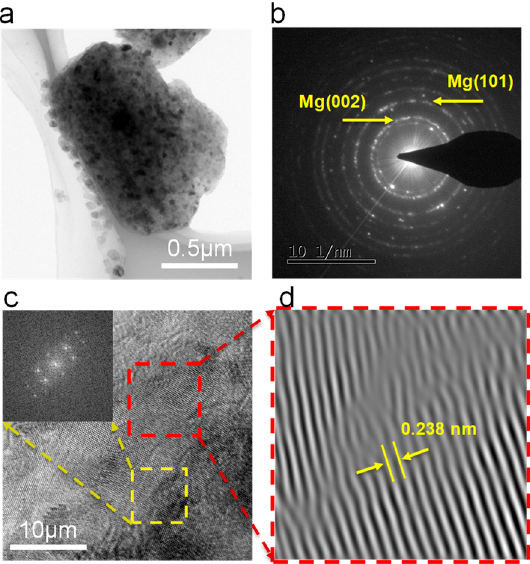
Figure 4. TEM analysis of Mg-Zn powder after milling for 30 h: ( a ) bright-field TEM image; ( b ) SAED pattern; ( c ) high-resolution image with FFT inset; ( d ) corresponding inverse FFT image.